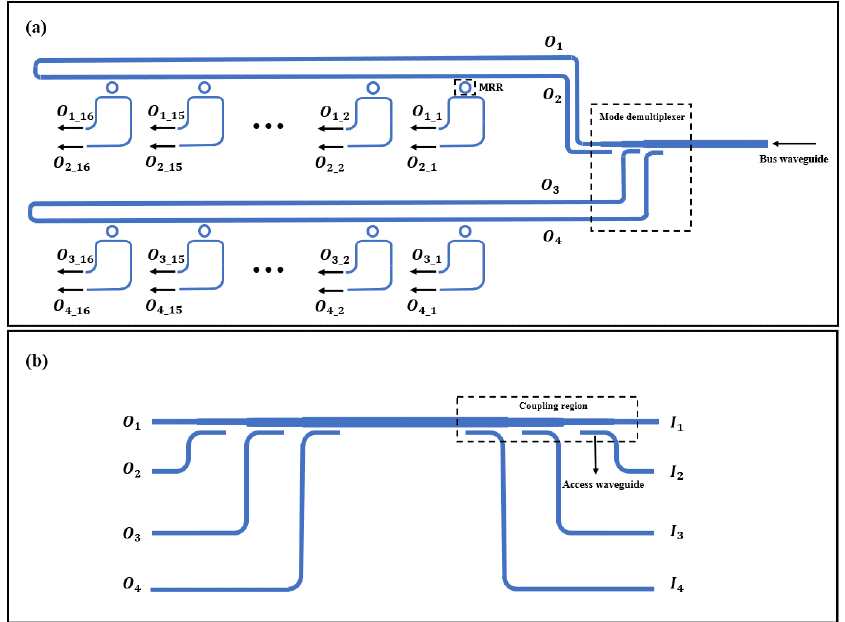
Figure 1. Schematic of the ( a ) 64-channel hybrid WDM-MDM demultiplexer, ( b ) 4-channel cascaded ADCs mode (de)multiplexer.